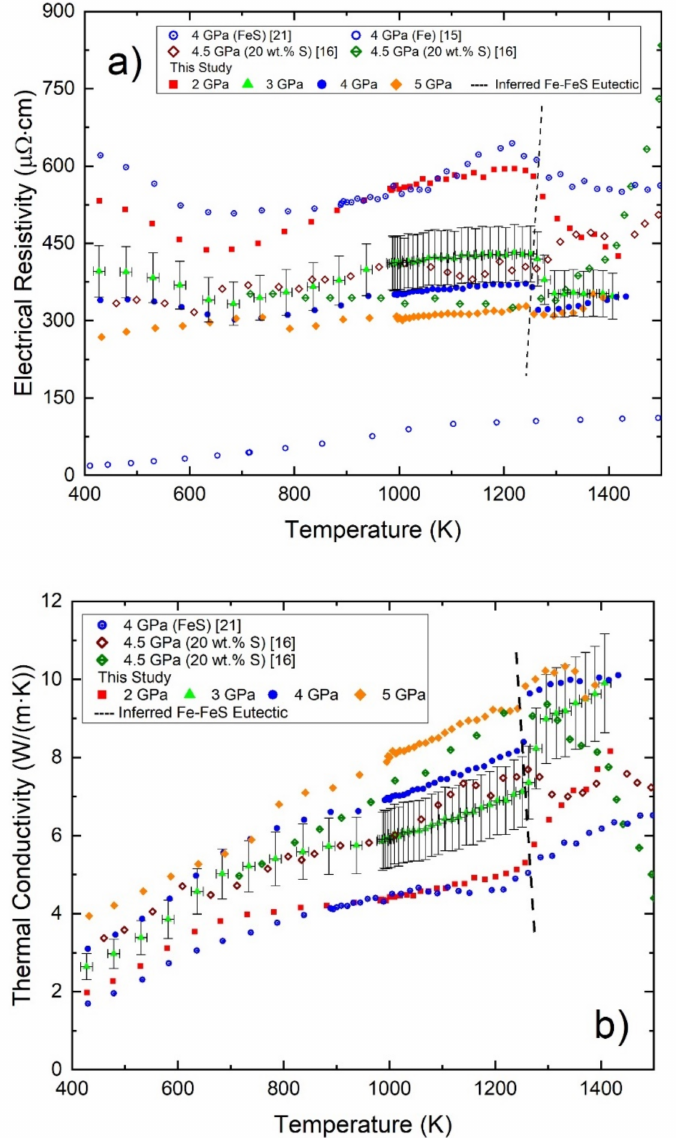
Figure 1. ( a ) Measured electrical resistivity of Fe-FeS at pressures of 2–5 GPa as a function of temperature. Sulfur contents (wt. %) of the samples at each pressure are: 29.56 ± 0.05 (2 GPa); 26.17 ± 0.05 (3 GPa); 25.68 ± 0.07 (4 GPa); 23.76 ± 0.06 (5 GPa). Results of this study are compared to three previous studies and include end-member compositions. The dashed line indicates the transition from solid to molten states and was used to delineate eutectic temperatures. ( b ) Electronic components of thermal conductivity as a function of temperature of Fe-FeS calculated from the electrical resistivity measurements using the Wiedemann–Franz law and the Sommerfeld value of the Lorenz number. Results of this study are compared to two previous studies. Data of the pure Fe end-member are not shown for scaling purposes (>12 W · m − 1 · K − 1 ). The dashed line indicates